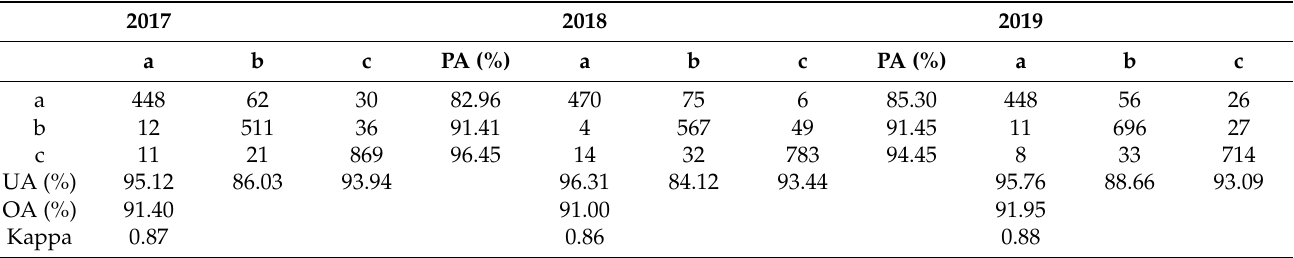
Table 1. Visual interpretation results of winter wheat in Shijiazhuang in 2017, 2018, and 2019. PA: producer’s accuracy; UA: user’s accuracy; OA: overall accuracy; a: winter wheat; b: non-vegetation; c: non-wheat